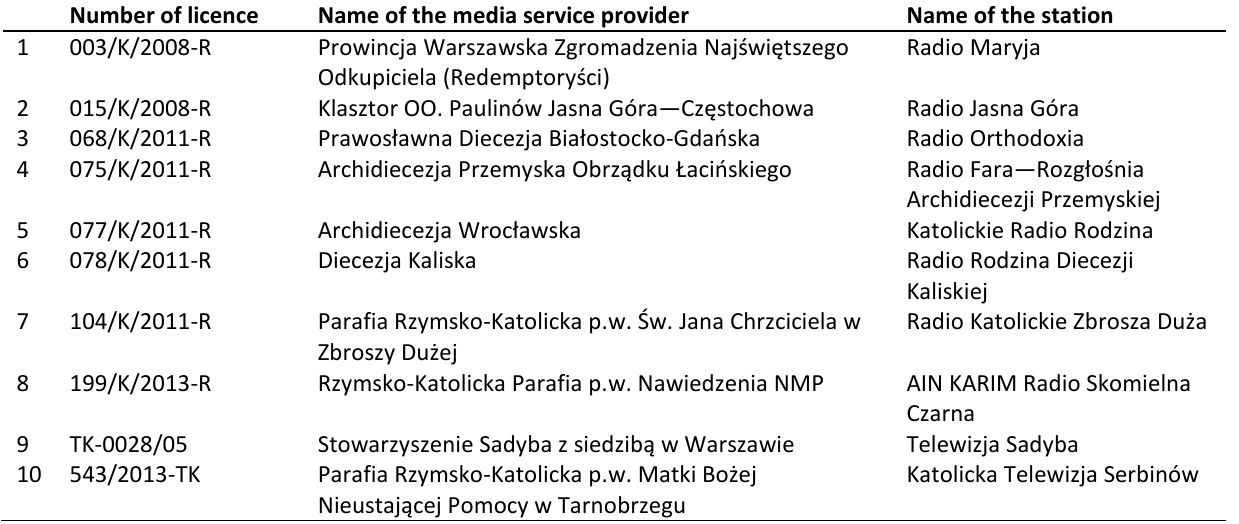
Table 4. Social broadcasters in Poland